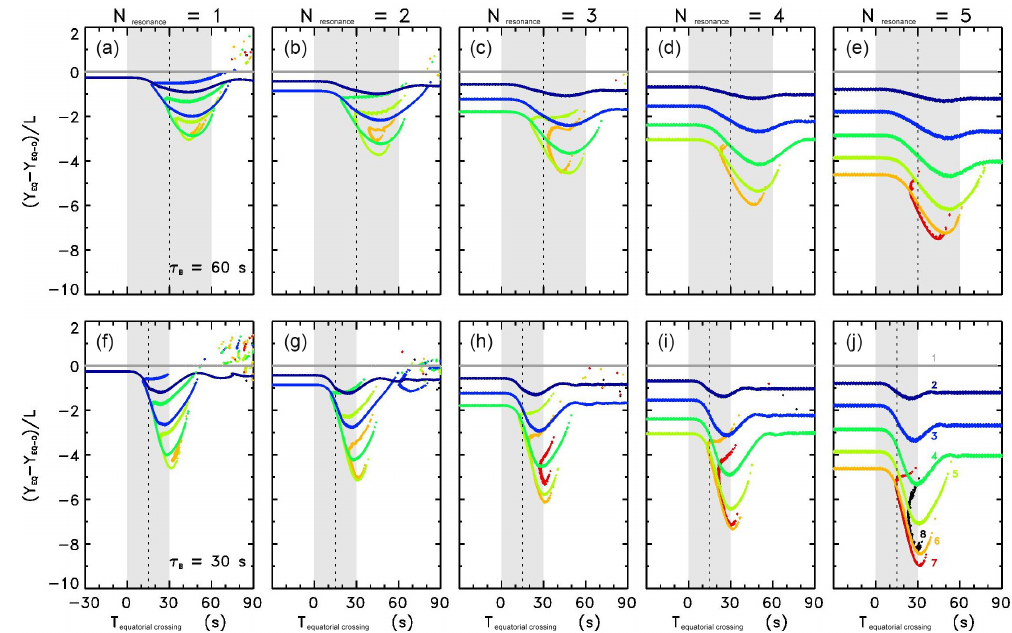
Figure 10. Identical to Fig. 3 but for different H + energy (from N = 1 to N = 5 from left to right panels) and for two different reconfiguration timescales (60 and 30s in top and bottom panels, respectively). The equatorial crossing number is color-coded as indicated in the lower right panel.